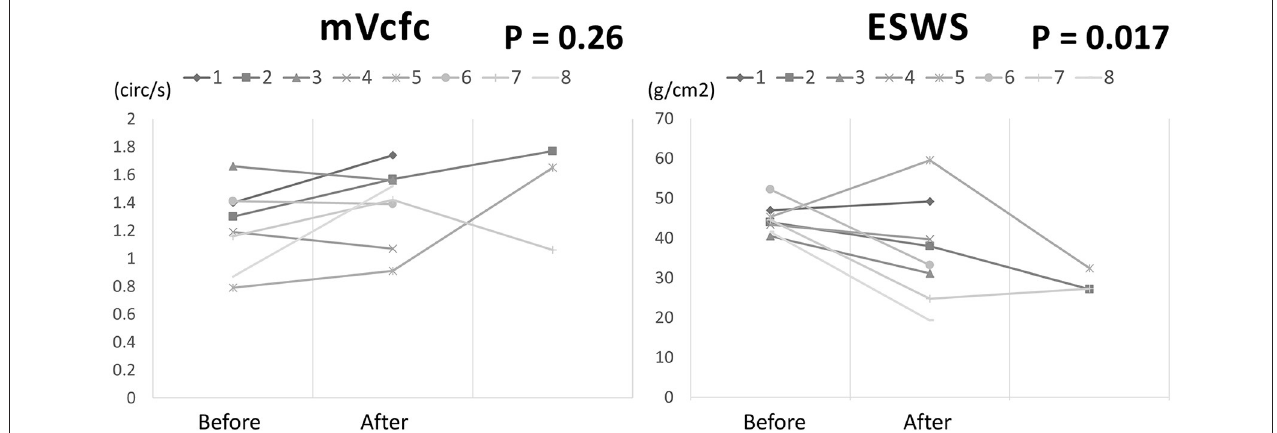
FIGURE 4 | The changing of mVcfc and ESWS before and after Dobutamine administration in 8 cases of the management